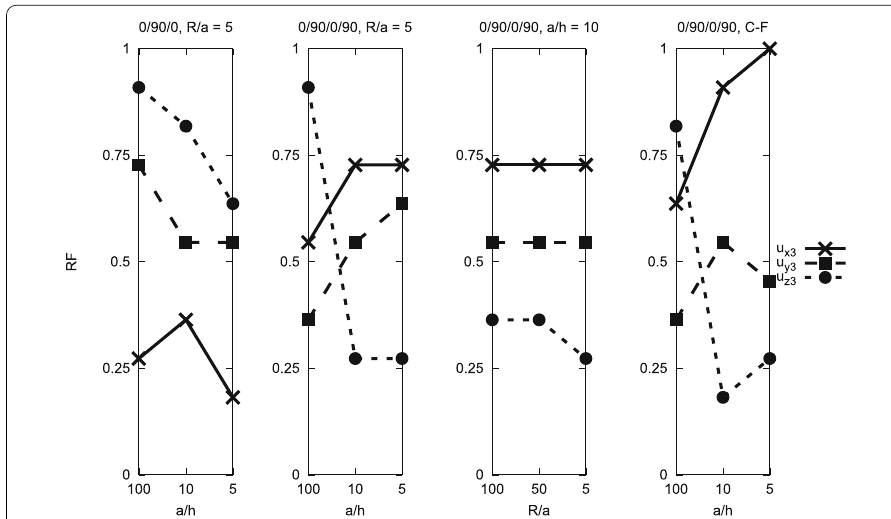
Fig. 13 RF for second-order displacement variables